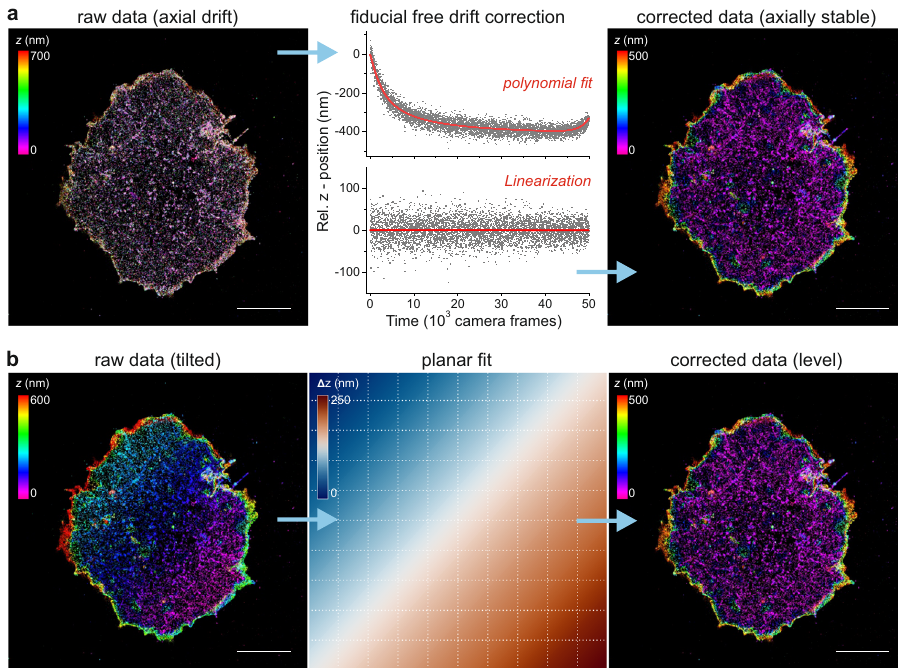
Fig. 3 Fiducial free drift and tilt correction of dTRABI data. CD4 WT on Jurkat cells is shown, where the membrane was labeled using Alexa Fluor 647- conjugated primary antibody (OKT4). a Principle of the fi ducial-free correction of axial drift. Left: representative, color-coded high-resolution dTRABI image of an axially unstable sample. Due to the temporal change of the axial coordinate, the resulting image does not exhibit axially distinct features. Middle: by extracting the axial localization distribution of the thin membrane layer per frame and tracking it over the entire stack, a spatio-temporal drift trace can be plotted (top). Fitting of the raw data (gray squares) by a high-order polynomial (red line) allows the temporal linearization of the localization data, leading to a stable axial mean value over time (bottom). Right: re-rendering of the drift-corrected localization data reveals a color-coded dTRABI image exhibiting distinct, high-density clusters of CD4 below another, disperse, layer. b Principle of the fi ducial-free correction of axial tilt. Left: representative, color-coded high-resolution dTRABI image of an axially tilted sample. Middle: the axial tilt of the sample is extrapolated by fi tting a plane to the raw image. Afterwards, the data are linearized by subtracting the local plane-value from the raw localization. Right: the tilt-corrected image exhibits a homogeneous color-code in the lowest data layer, indicating no residual axial tilt. Exemplary drift and tilt were simulated for illustration but based on real data (the displayed cell displayed both signi fi cant drift and tilt). Right columns represent experimentally corrected real data on which the drift and tilt were projected. For all experimental data, axial drift correction was performed prior to a tilt test and correction. Scale bars, 5 μ